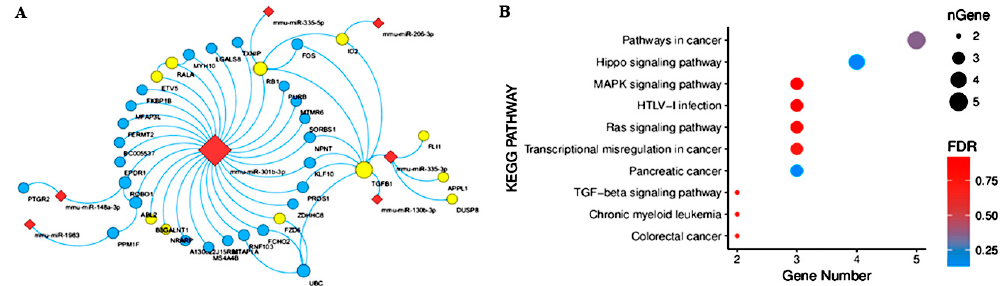
Figure 6. miRNA–mRNA network in the MSTN-KO group. ( A ) Interactive network of upregulated miRNAs and downregulated mRNAs in the MSTN-KO group. ( B ) KEGG pathway enrichment of DEGs in the miRNA–mRNA network.